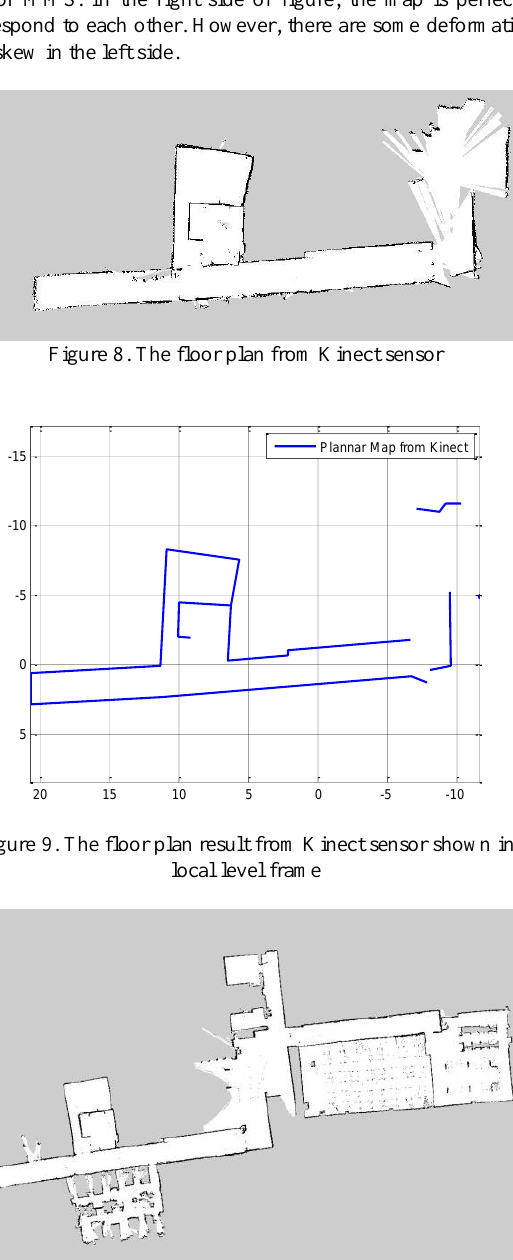
Figure 10. The floor plan from laser scanner